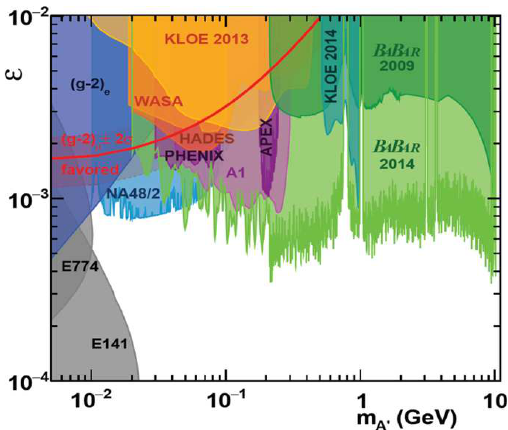
Figure 1. Compilation of existing dark photon constraints in the parameter space ǫ Y vs dark photon mass, for decays in light lepton